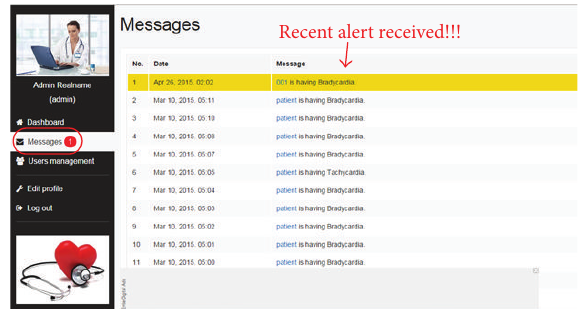
Figure 5: Alarming interface of remote patient monitoring